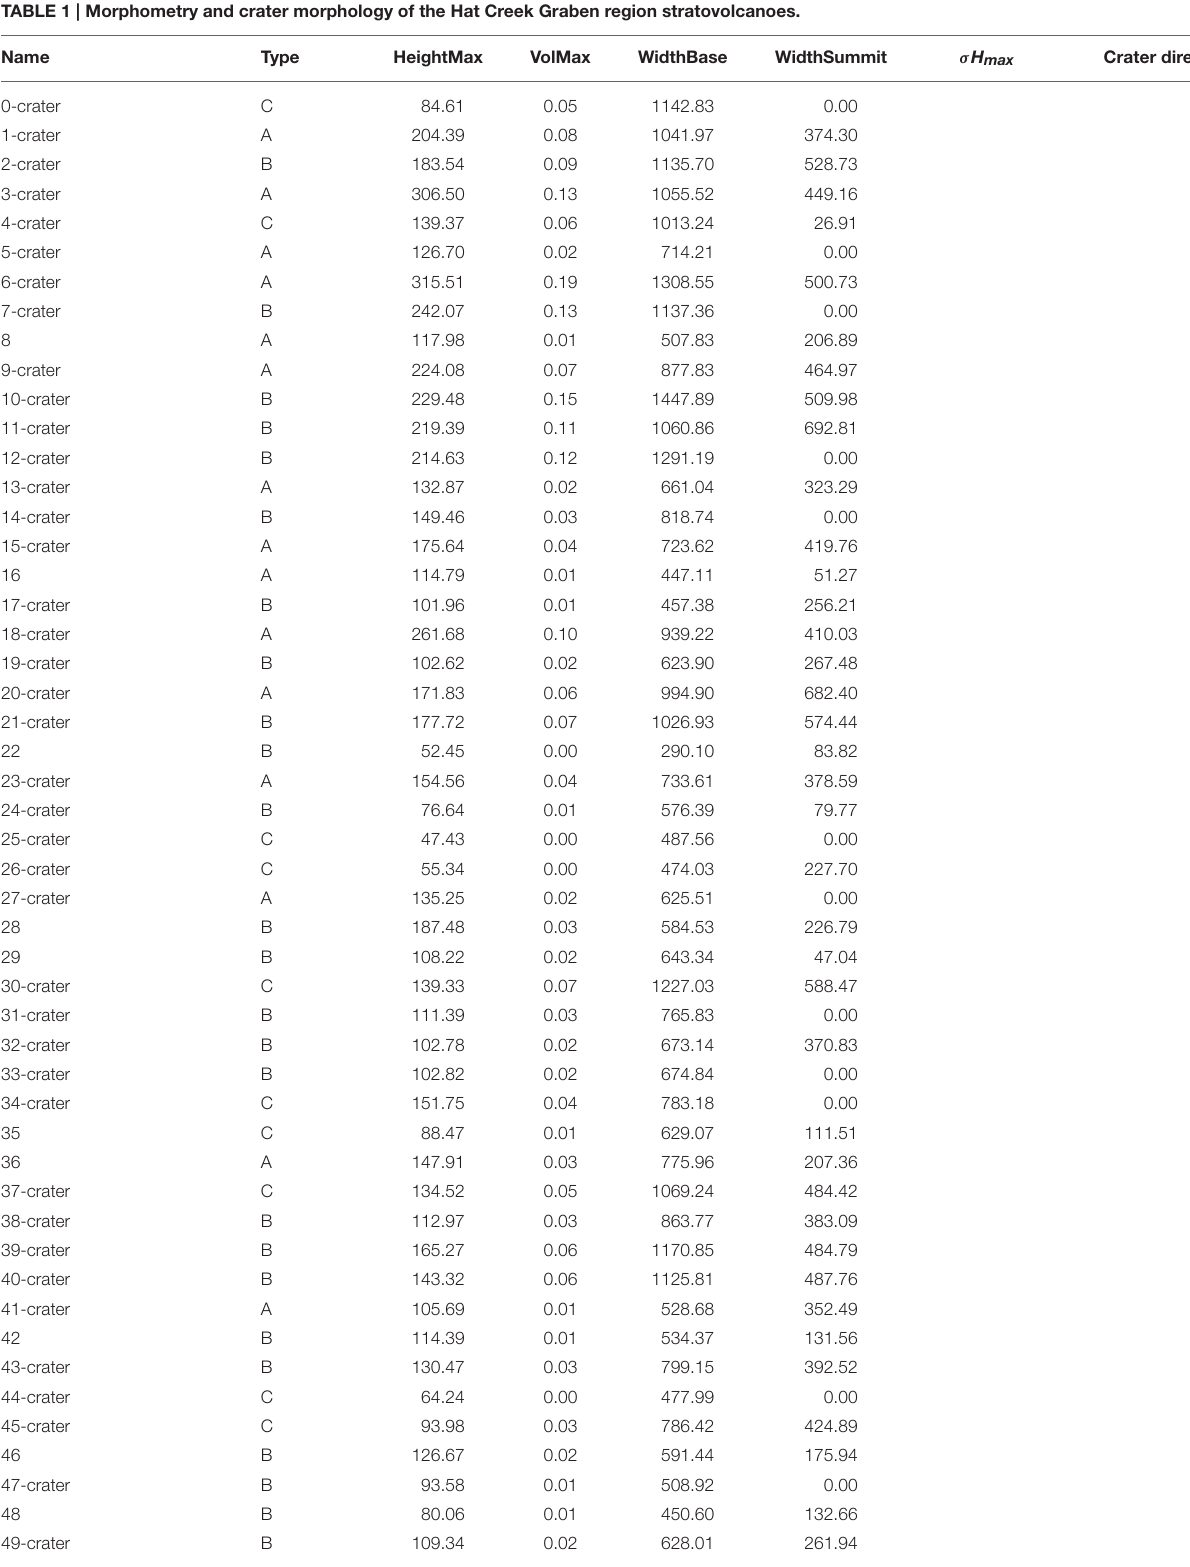
TABLE 1 | Morphometry and crater morphology of the Hat Creek Graben region